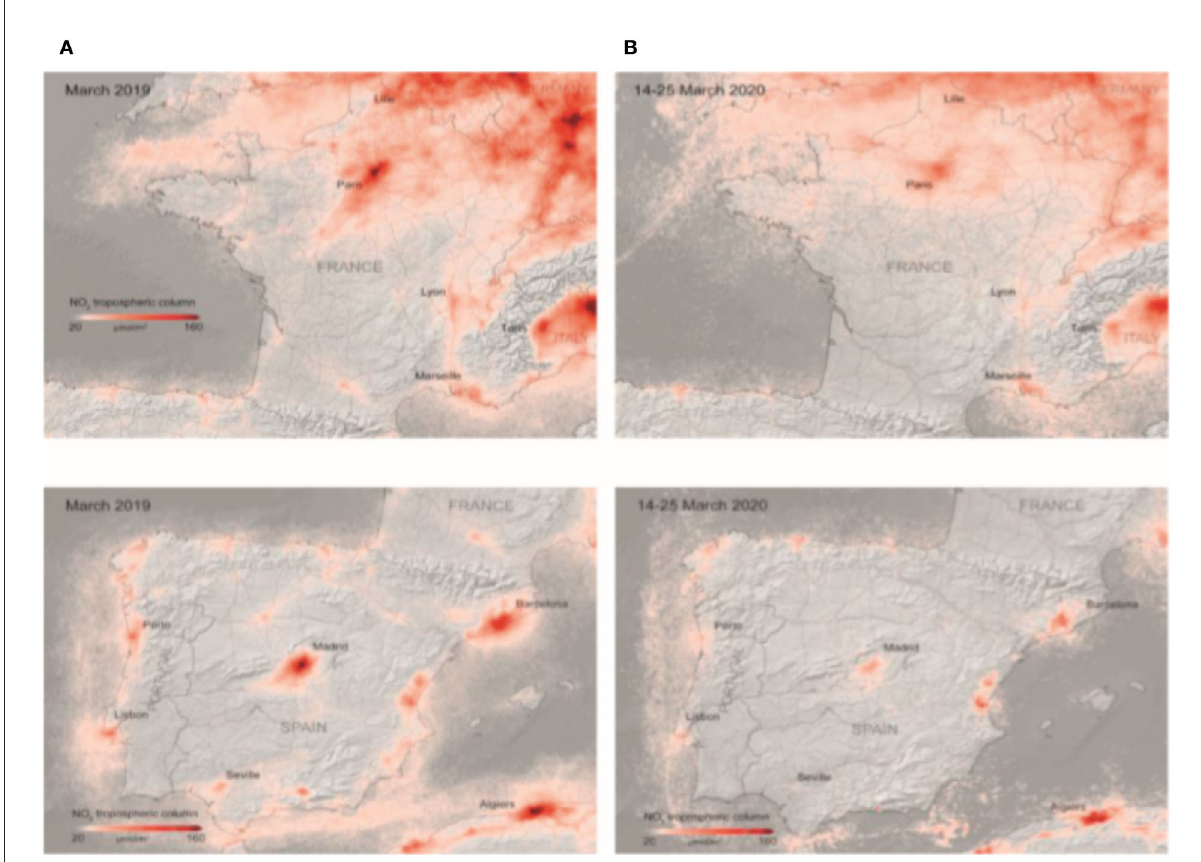
FIGURE1 (A, B) Changes in NO 2 emissions levels in France and Spain before March 19 and 14–25 March, 2020. Source: European Space Agency (2020).